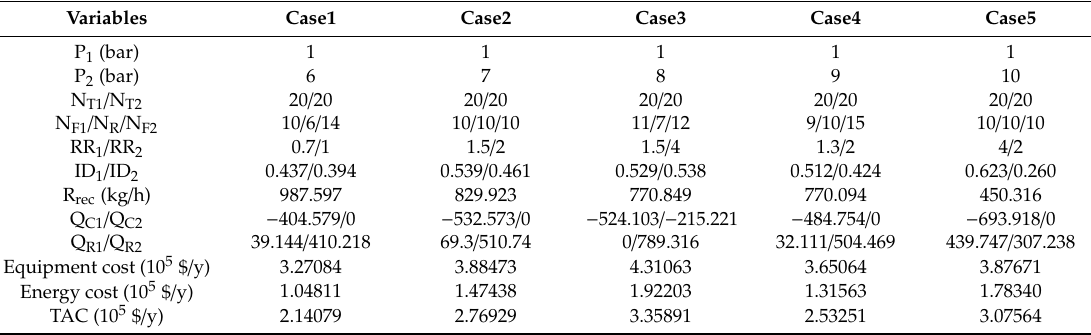
Table 3. Case studies of pressure swing distillation (PSD) with partial heat integration.